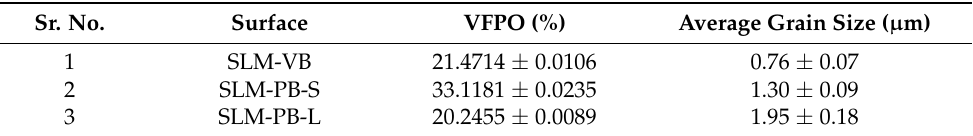
Figure 5. Pole figures, orientation distribution figures (with lattice) and misorientation distribution figures. ( a ) SLM-VB; ( b ) SLM-PB-S; ( c ) SLM-PB-L. Table 4. The VFPO and grain sizes of SLM Ti6Al4V samples. Sr.